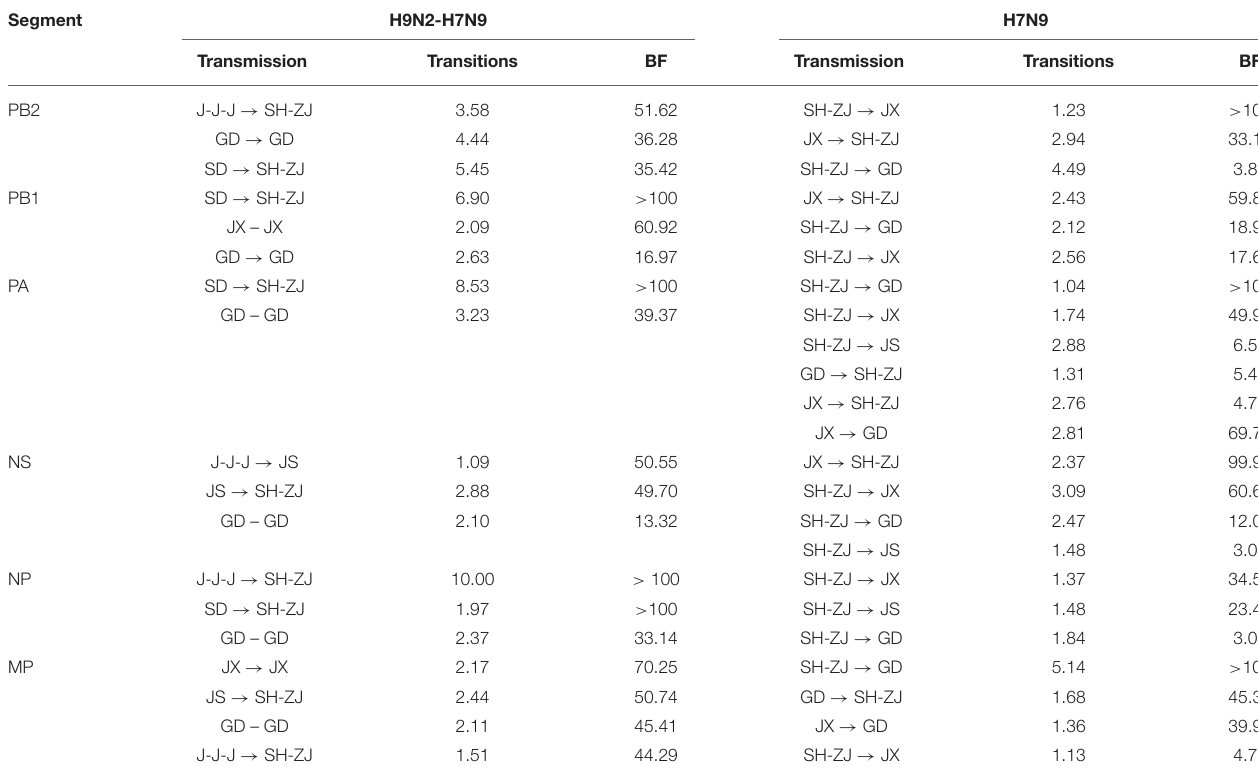
TABLE 2 | Statistical performance of viral propagation paths.